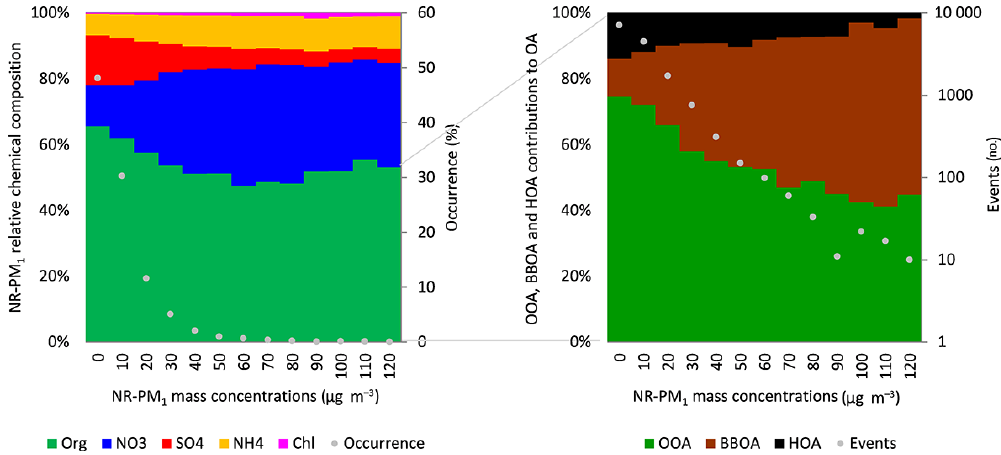
Figure 8. NR-PM 1 relative chemical composition (left) and OA factor contributions (right) averages as a function of NR-PM 1 mass con- centrations (bins of 10µgm − 3 ) . Occurrence (%, left) and number of pollution events (no., right) are indicated (solid dots) for each NR-PM 1 bin. Note that one event corresponds to one 30min